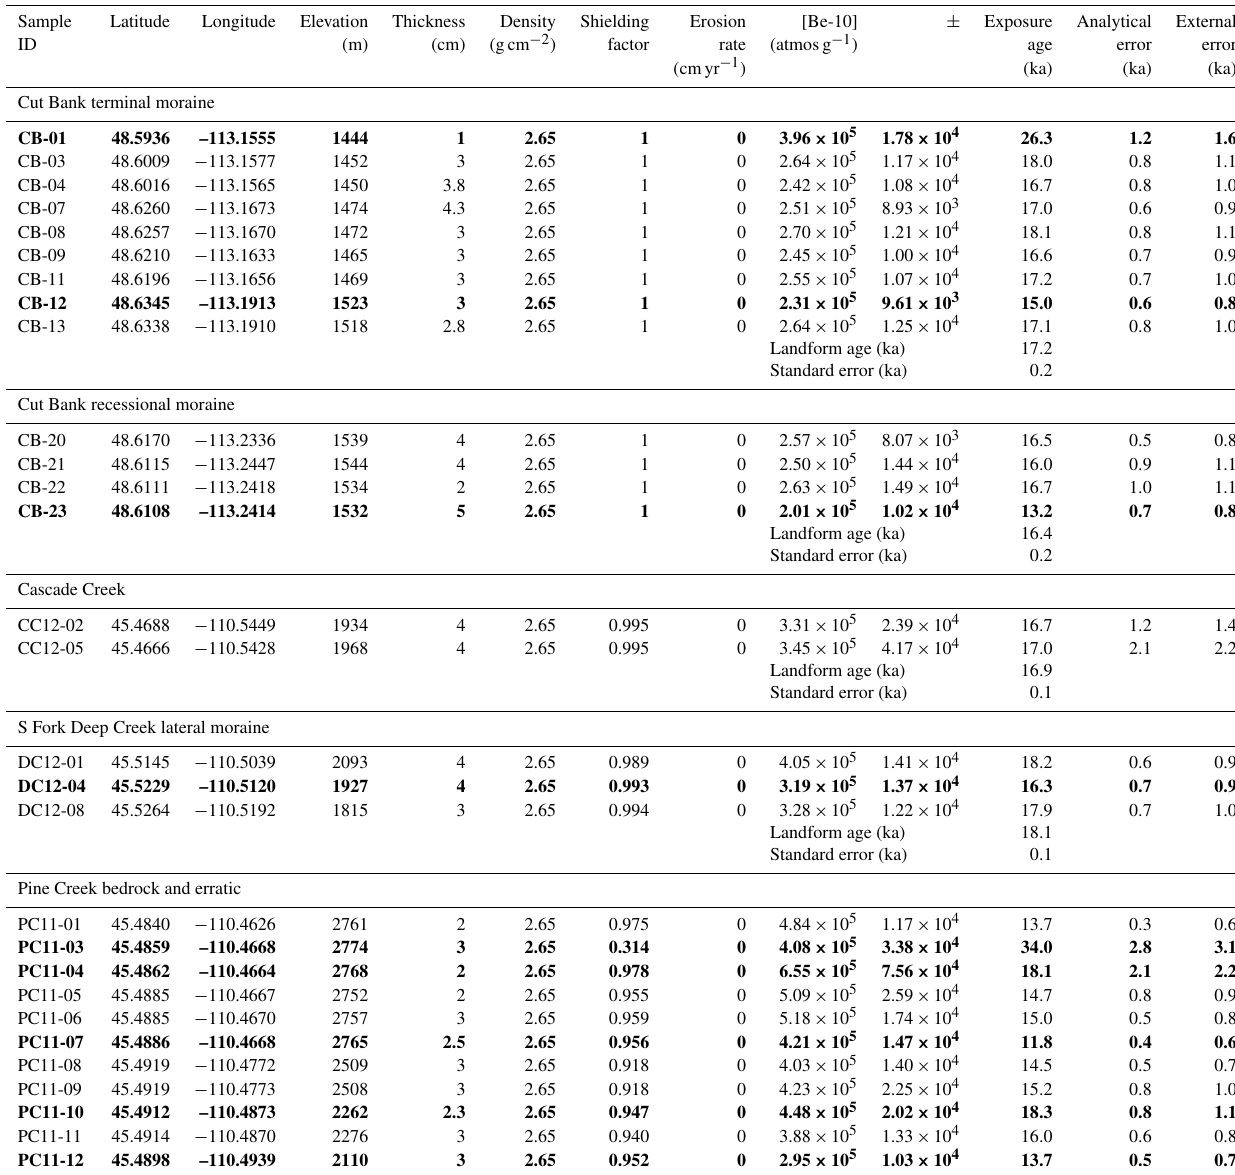
Table 1. Cosmogenic 10 Be sample information and exposure ages.